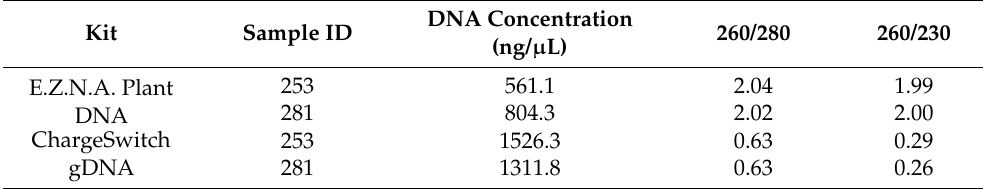
Table 1. Comparison of DNA extraction kits using Nanodrop measurements for assessment. Ex- tracted DNA (1 µ L) from two samples was measured with an ND-1000 spectrometer. Sample ID refers to identity of samples from the TanAsp collection, 260/280 is a measurement of DNA/protein ratio, and 260/230 is a measure of DNA/contaminant ratio. The preferred kit was chosen on the basis of both better